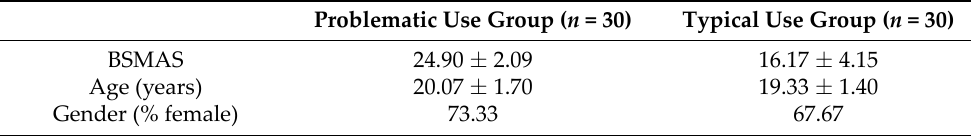
Table 1. Descriptive statistics of the problematic use group and typical use group (M ± SD).